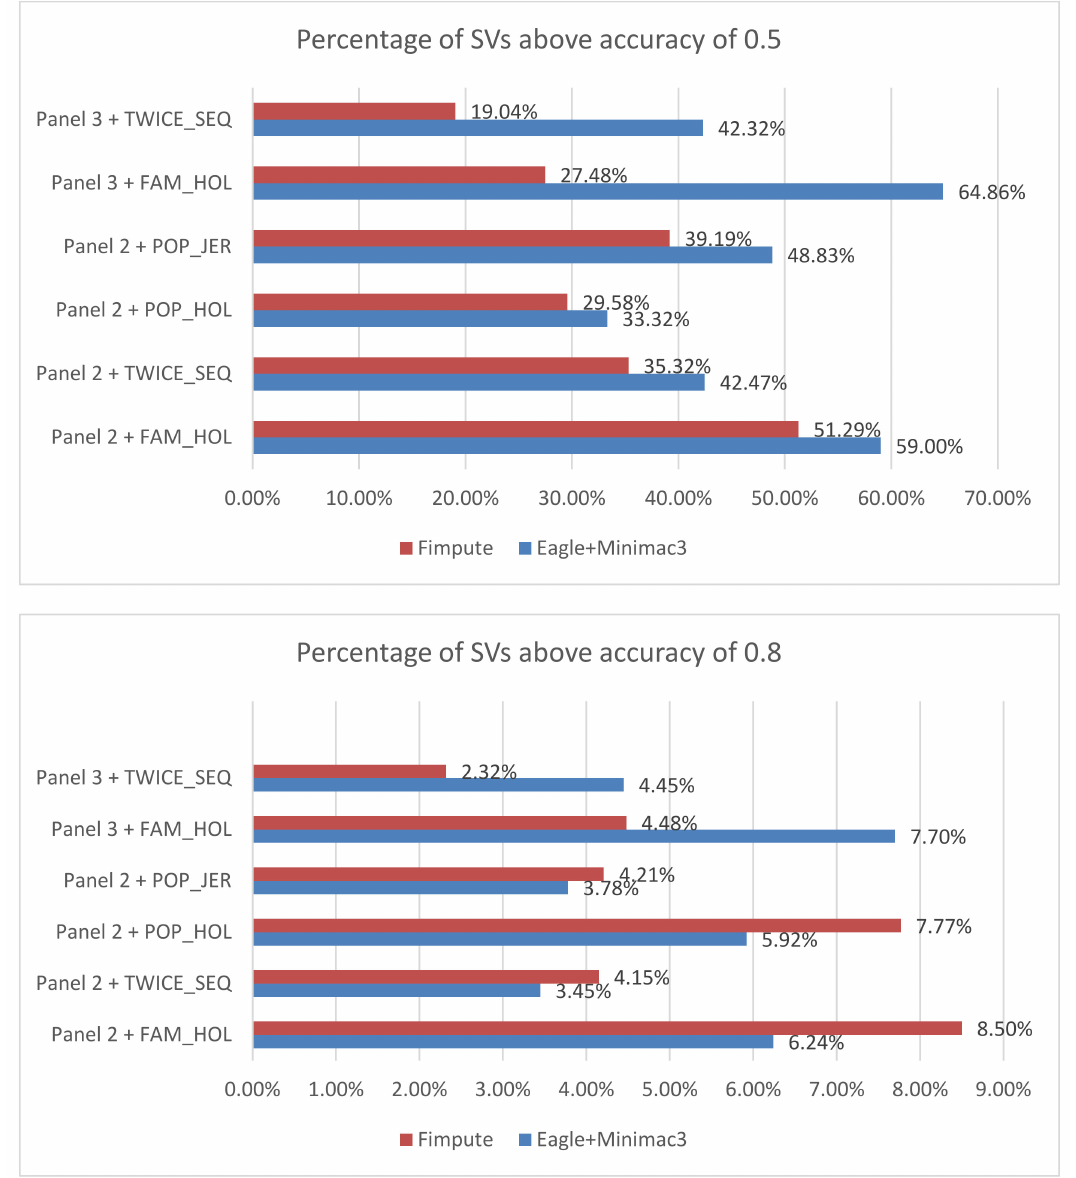
Figure 1. Percentage of deletions with imputation accuracy above thresholds 0.5 (top panel) and 0.8 (bottom panel) for Eagle + Minimac3 and FImpute. Y axis: imputation scenarios labelled by reference panel and structural variant (SV)